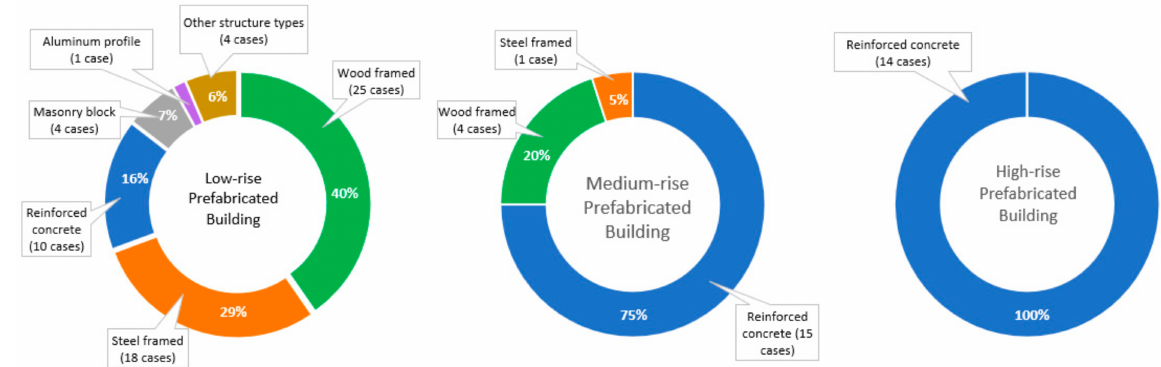
Figure 10. Relation between prefabricated building heights and building structural